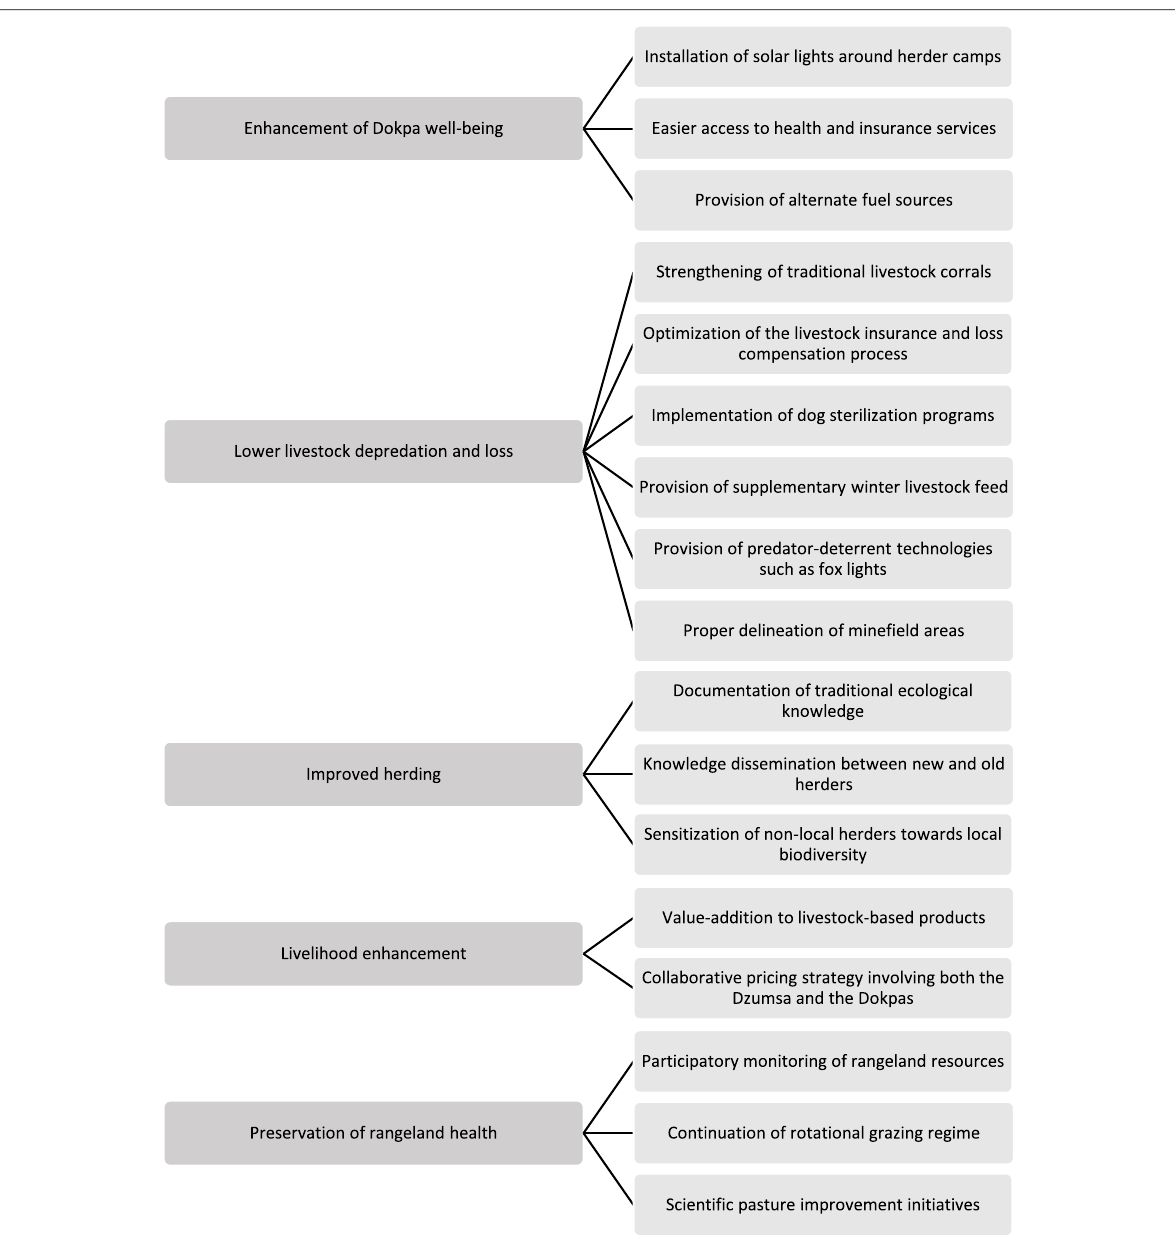
Fig. 9 Recommendations for a facilitative environment for the traditional Dokpa pastoralism in North